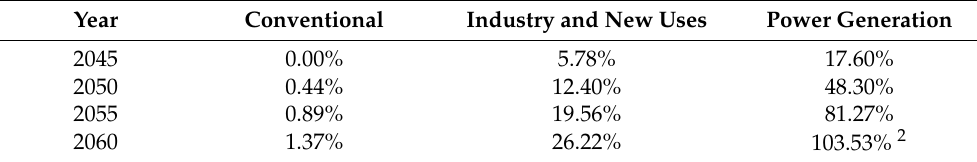
Table 3. P H, sector, year values.